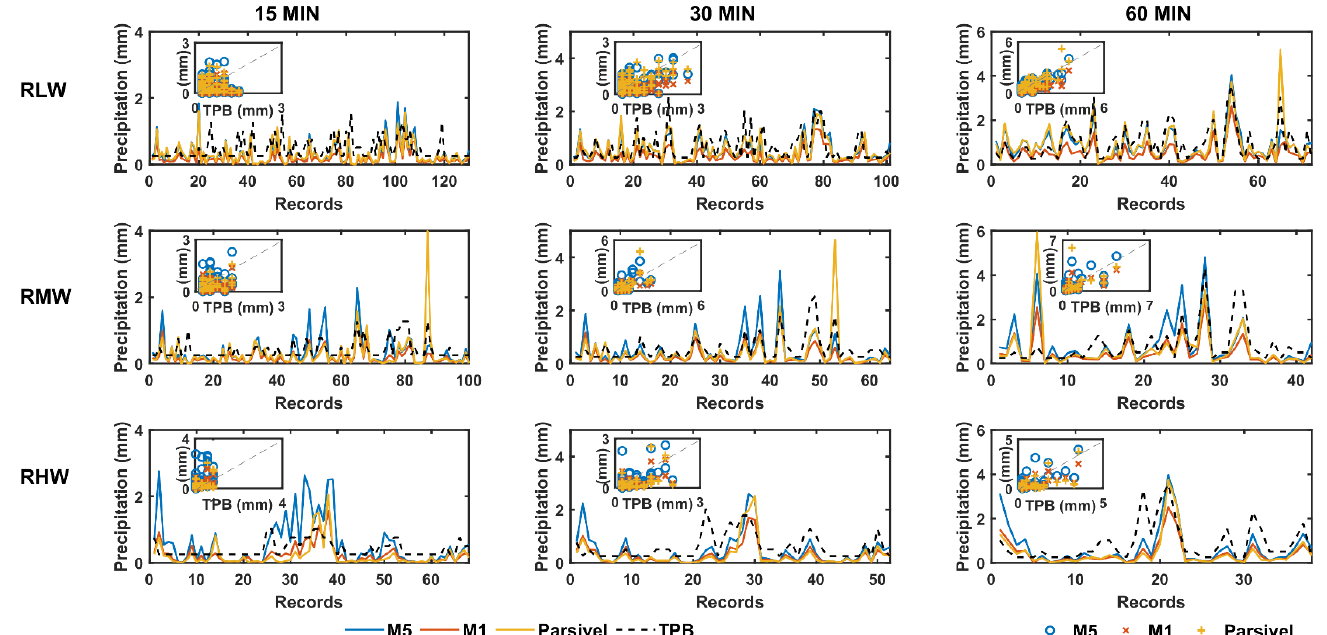
Figure 9. Comparison of liquid precipitation series for different time-scales (columns) and for low ( RLW ), medium ( RMW ) and high wind speed group ( RHW ). Values correspond to TPB measurements (black dashed line), Parsivel measurements (yellow line) and corrected precipitation with density model 1 (M1 in red line) and 5 (M5 in blue line). In each plot, a scatterplot is included of Parsivel, M4 and M5 respect to TPB as reference. The dashed gray line shows the slope m = 1.